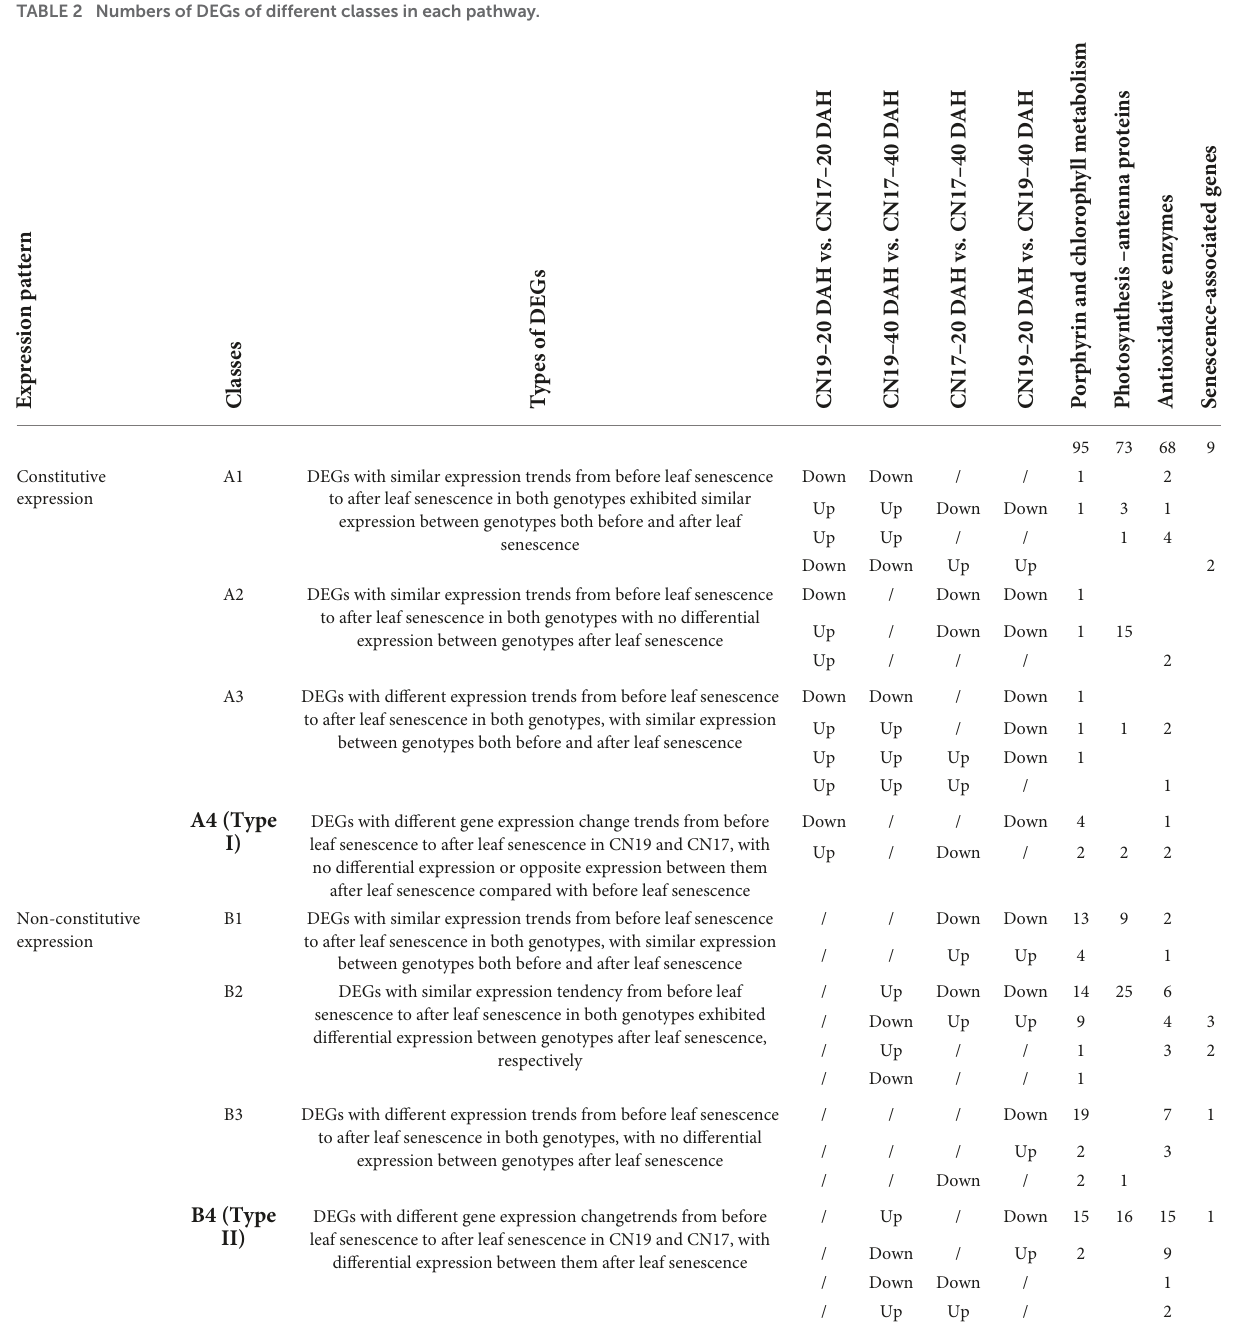
TABLE 2 Numbers of DEGs of different classes in each pathway.